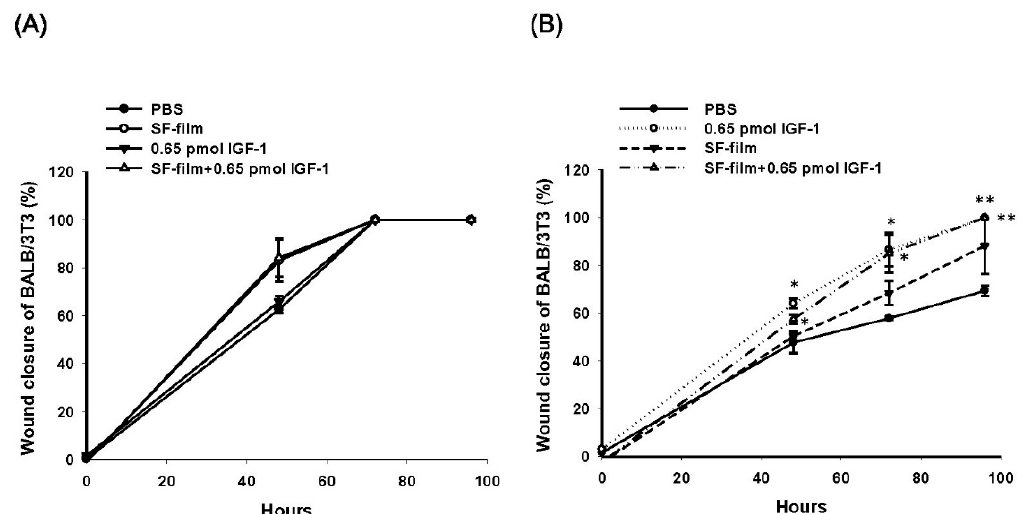
Figure 6. Migration of BALB/3T3 fibroblasts in response to IGF-1 (0.65 pmol), SF-film, and IGF-1-loaded SF-film (SF-film containing 0.65 pmol of IGF-1) treatments. Quantification of cell wound closure after IGF-1, SF-film, or IGF-1-loaded SF-film treatment in regular medium ( A ) or hyperglycemic medium ( B ). Statistically significant differences between the PBS and treatment groups were determined by Dunnett’s multiple comparison post hoc test. * p < 0.05 and ** p < 0.01; n = 4; all error bars represent the standard error of the mean .